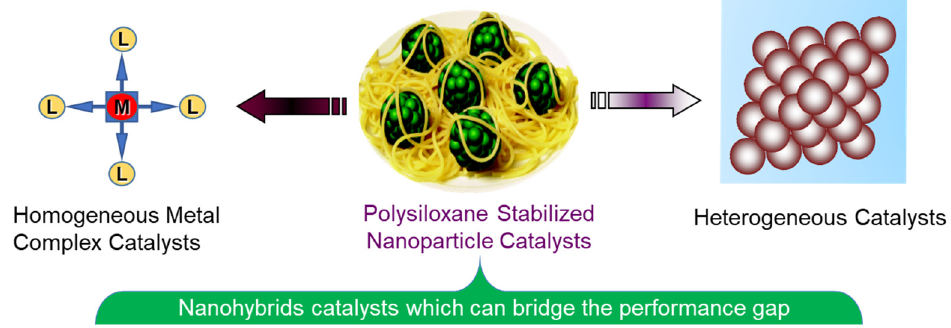
Figure 3. Polysiloxane-stabilized nanoparticle catalysts with both homogenous and heterogenous catalytic characteristics.